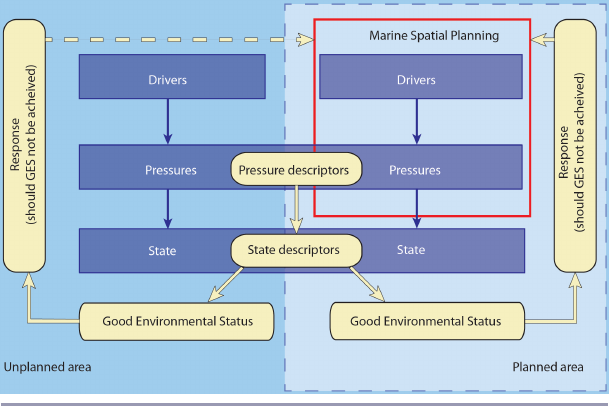
Fig. 1 . Marine spatial planning (MSP) and